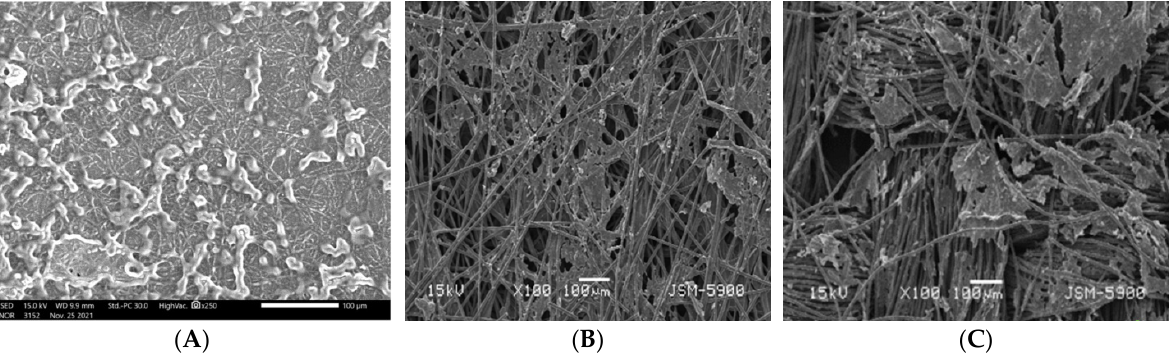
Figure 4. SEM image for the used carbon nanofiber: ( A ), carbon paper; ( B ) carbon cloth; ( C ) anodes in the microbial fuel cell.